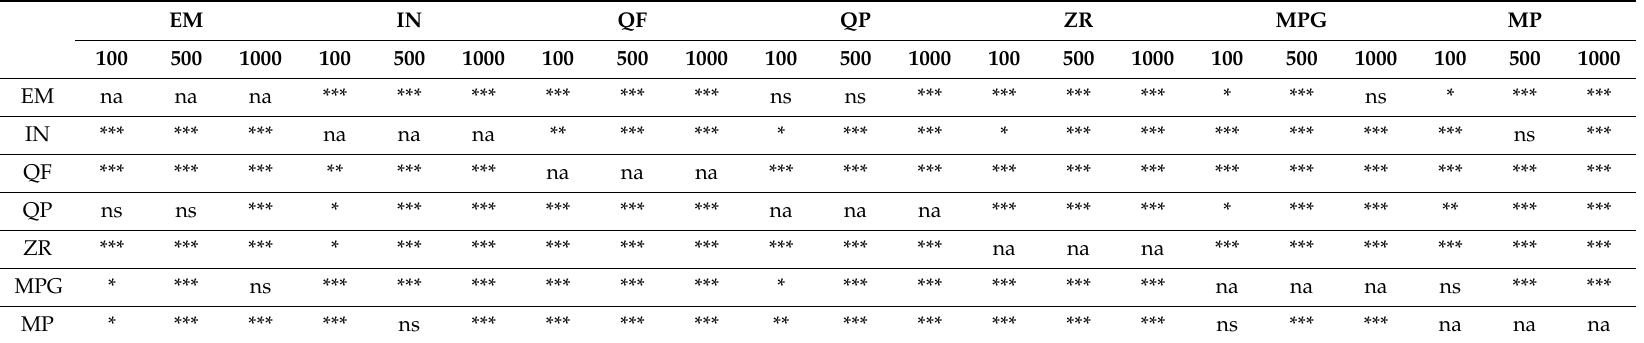
Table 6. Degrees of statistical significance of Mann–Whitney tests comparing mean Ct values of C. parvum real-time PCR according to DNA pretreatment / extraction protocols for the concentrations of 100, 500 and 1000 oocysts /